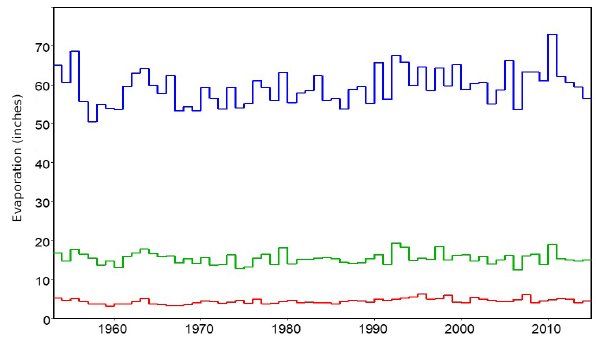
Figure 1. Major rivers and largest cities in Texas.